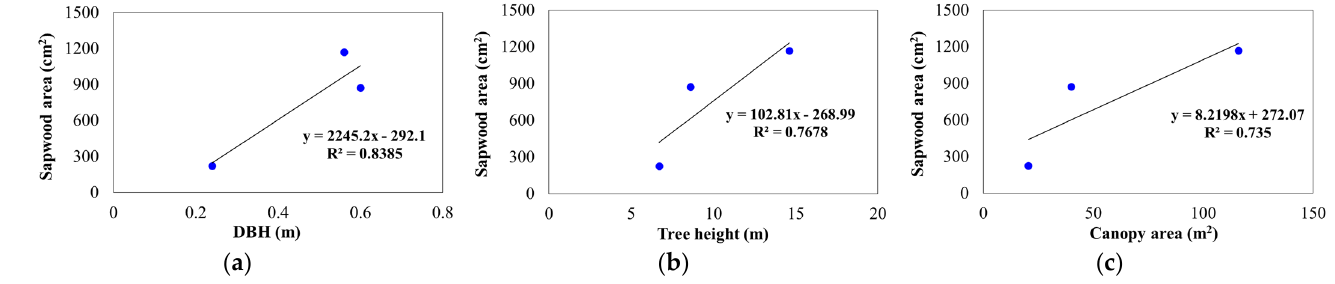
Figure 4. Correlations between DBH, height and canopy area with sapwood area for the C. maculata , M. styphelioides and L. confertus used in these experiments. ( a ) DBH and sapwood area; ( b ) Tree height and sapwood area; ( c ) Canopy area and sapwood area.